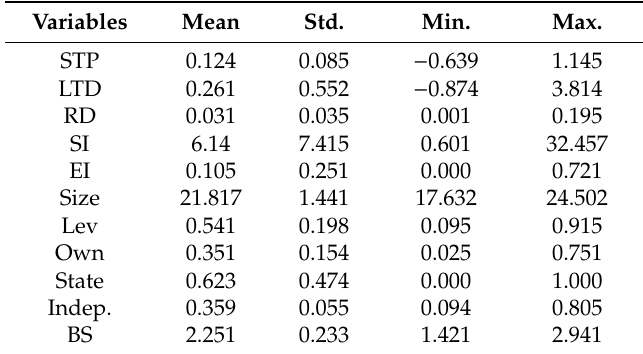
Table 3. Descriptive